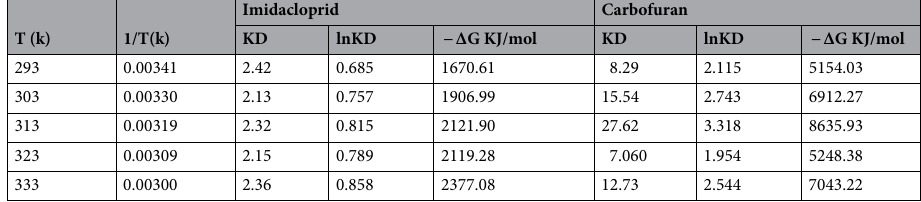
Table 5. Van’t Hoff parameters for the adsorption of imidacloprid ( ■ ); and carbofuran ( ● ); on Silica anchored GO composite. The values of ∆H (kj mol −1 ) and ∆S (JK −1 mol −1 ) for imidacloprid are − 3400.42 and 4.323 and for carbofuran are 27,381.66 and 112.687